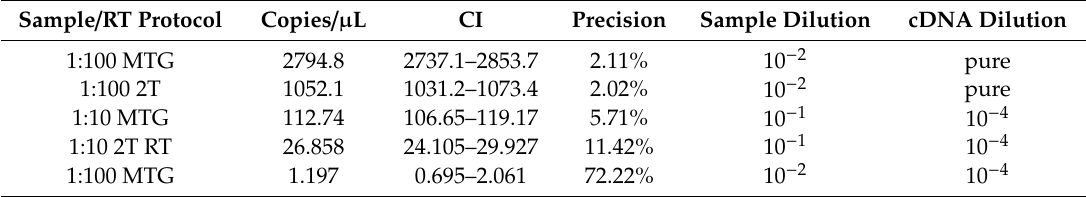
Table 2. Digital Polymerase Chain Reaction (RT-dPCR) results after cDNA dilution of 0 mosquito samples with high viral